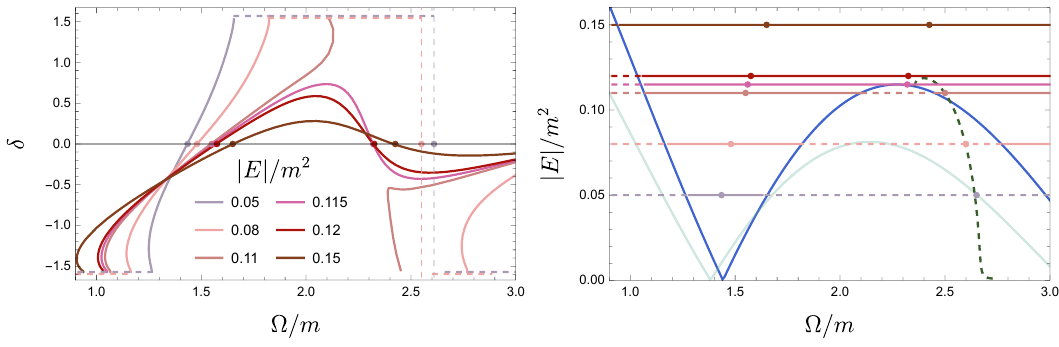
Figure 9 . Continuous lines are black hole embeddings, whereas dashed lines are Minkowski (with a slight vertical offset for clarity). Left : relative angle δ for different embeddings at various fixed values of the electric field and with r h /m = 0 . 7 for varying Ω /m . Right : this is a zoom of the first lobe region in figure 3, where the color code for constant | E | /m 2 lines corresponds to the ones on the left plot. The dots indicate the frequencies where the angle δ either becomes zero in the BH segments, or flips sign in the Minkowski segments. In this later case, joining all the points gives the dashed green curve. The fact that this curve of Minkowski embeddings exits the lower lobe is related to the spiralling multivaluedness of the phase space curves in the vicinity of the critical embeddings. We have added another (dimmed green) lobed curve with higher temperature r h /m = 0 . 8 to show that the effect of rising the temperature is similar to that produced by increasing the electric field | E | /m 2